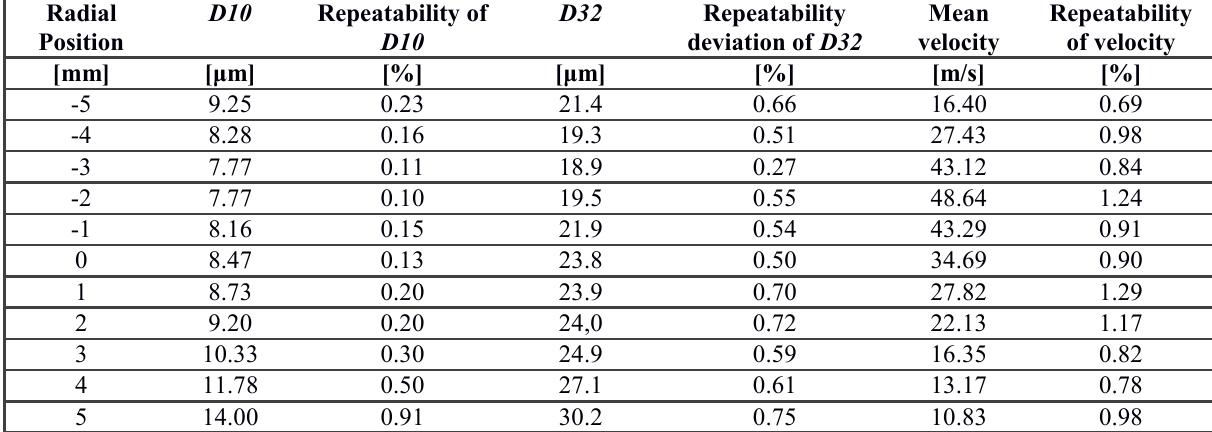
Fig. 3 . Contours of the data rate in three axial distances from the nozzle: a) 10 mm, b) 20 mm, c) 30 mm. Bottom: Contours of mean axial velocity in three distances from the nozzle: a) 10 mm, b) 20 mm, c) 30 Table 2. System B, statistics made from 9 measurements .